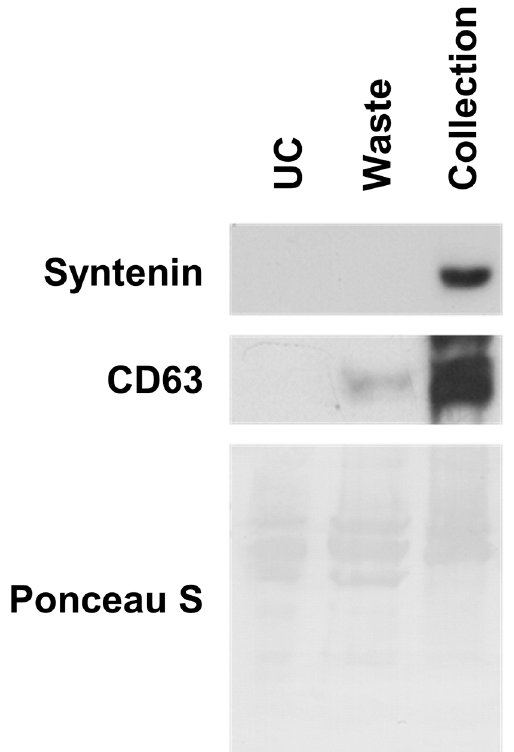
Figure 5. Separation of EVs from human serum using nanoporous PC membrane chip. Human serum EVs were separated by ultracentrifugation (UC) and nanoporous PC membrane chip. Original gel images are in Figures S7–S9.